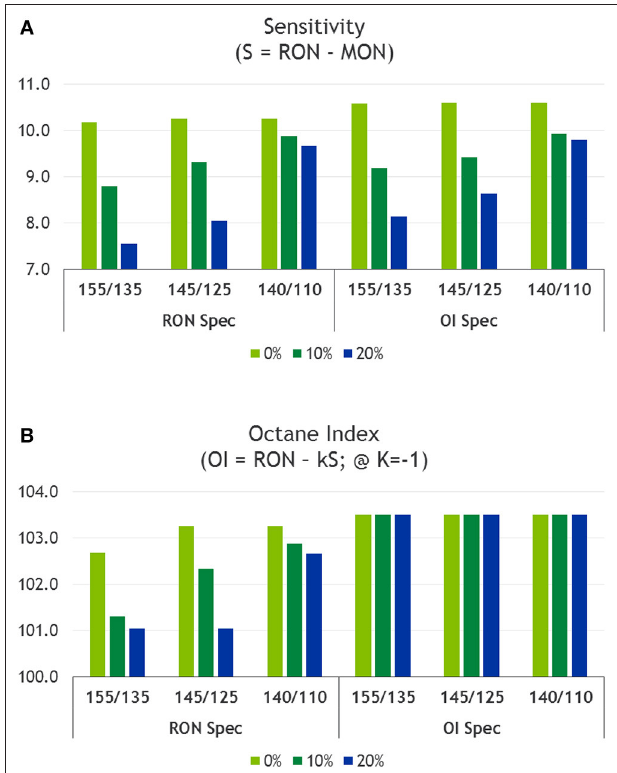
FIGURE 9 | Effects of ethanol blending RON (bRON) and MON (bMON) assumptions on (A) octane sensitivity, and (B) octane index of finished gasoline at 0%, 10% and 20% ethanol contents. The 3 bRON /bMON combinations were 155/135, 145/125, and 140/110, with blending sensitivities of 20, 20, and 30, respectively.